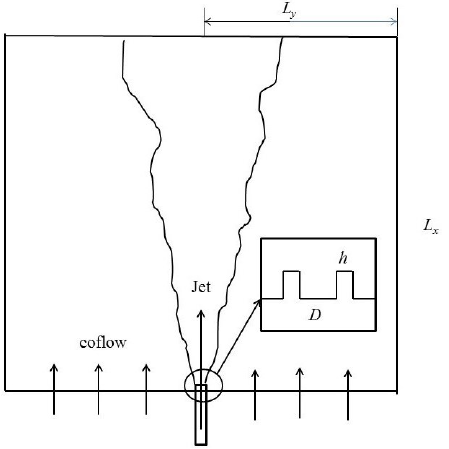
Figure 1. Schematic diagram of calculation